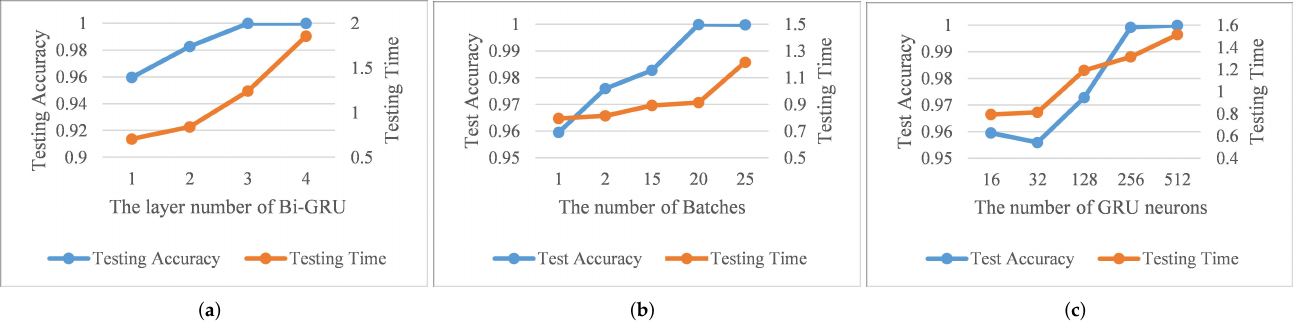
Figure 10. Accuracy and Testing time at different Hyperparameter. ( a ) Accuracy and Testing time at the different layer number of Bi-GRU; ( b ) Accuracy and Testing time at different number of Batches; ( c ) Accuracy and Testing time at different number of GRU neurons.